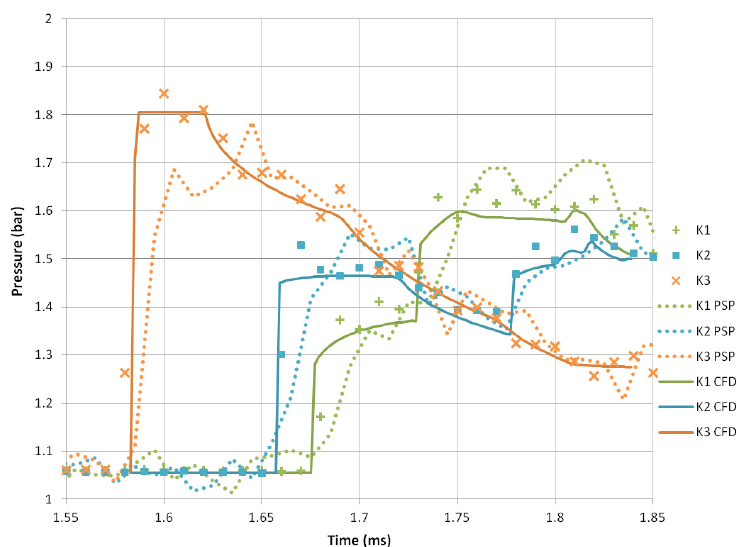
Figure 9. Pressure transducer measurements of M sharp